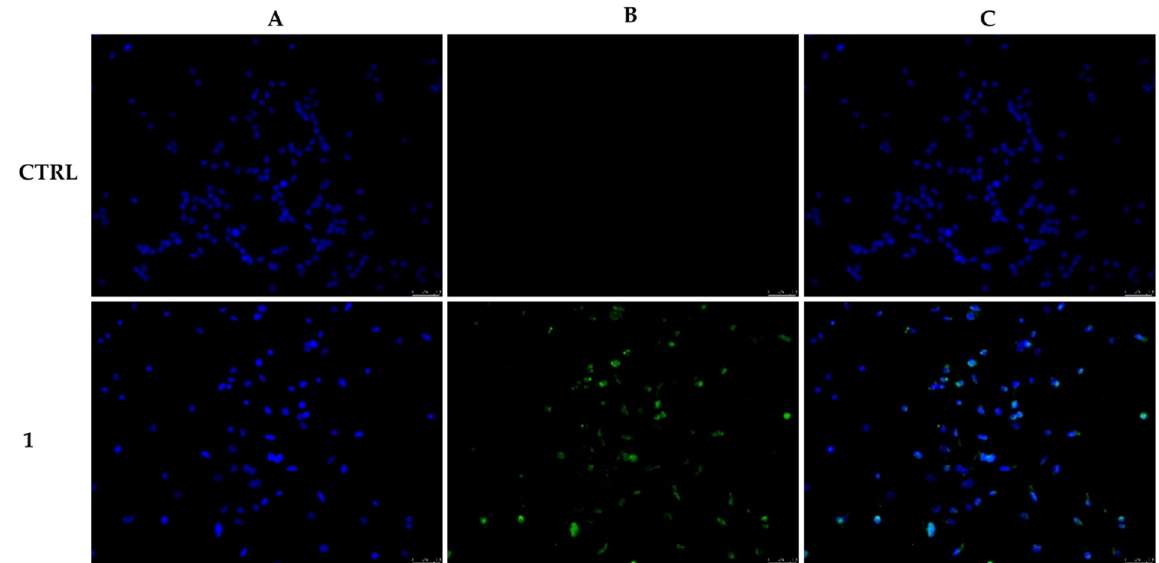
Figure 4. MCF-7 cells were exposed to compound 1 at its IC 50 value or with the vehicle DMSO (CTRL) for 24 h. Then, cells were incubated with the TdT enzyme and observed under an inverted fluorescence microscope at 20 × magnification. Apoptotic cells are indicated by a clear green nuclear fluorescence in compound 1 -treated cells. ( A ) DAPI (CTRL and 1 ) λ ex/em = 350 nm/460 nm. ( B ) CF TM 488A (CTRL and 1 ) λ ex/em = 490 nm/515 nm. ( C ) A merge. Fields are representative of three separate experiments.